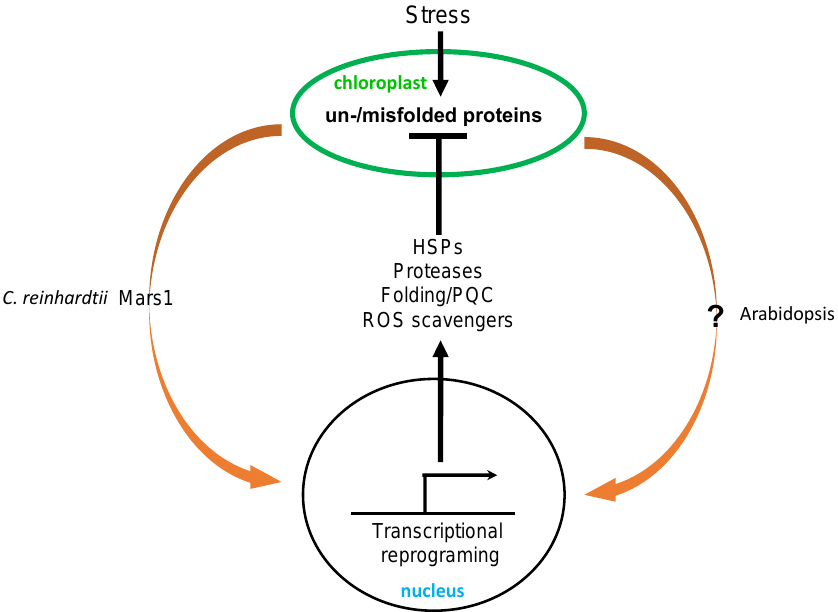
Figure 3. Chloroplast unfolded protein response (cpUPR). Stress such as high light intensity and deficiency of plastidic proteases leads to increased accumulation of unfolded and misfolded proteins in chloroplasts, which trigger cpUPR associated with activated transcription of genes encoding HSPs, proteases, and proteins involved in protein folding and quality control and ROS scavenging. Increased production of these proteins promotes protein folding, and the removal of misfolded proteins and ROS to protect chloroplast functions. In green algae C. reinhardtii , the Mars1 kinase in the cytosol is required for cpUPR. In Arabidopsis, the signaling mechanisms and components involved in the chloroplast-to-nucleus communication for activation of cpUPR have not been firmly established.